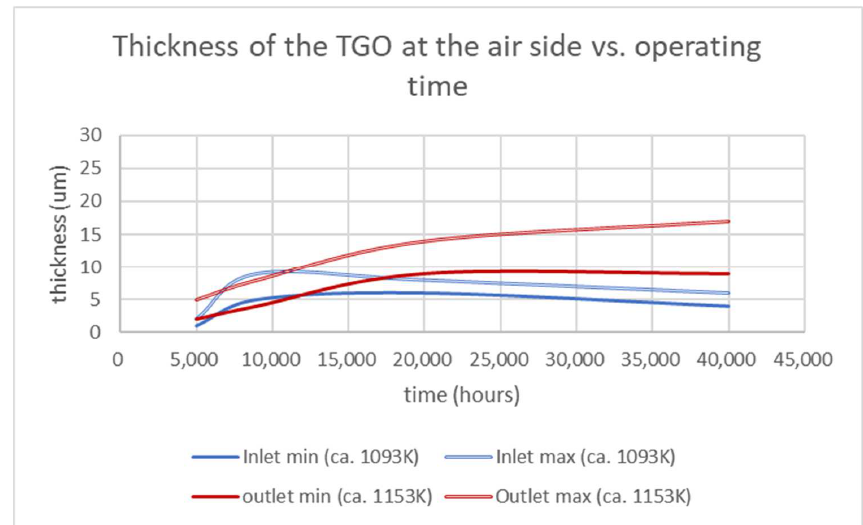
Figure 5. Graphical representation of the lower and higher thicknesses of the TGOs measured on interconnects extracted from similar stacks operated for differing periods (i.e., 5000; 9000; 20,000; 40,000 h).